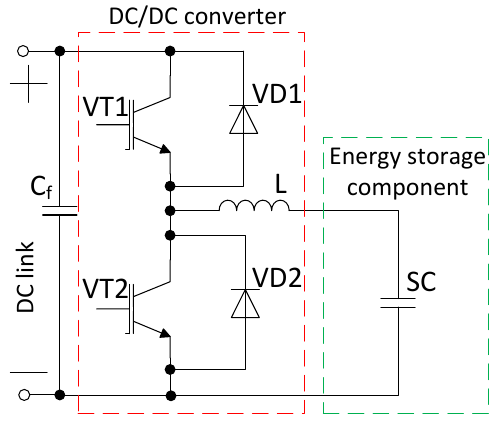
Fig. 2. Diagram of SC and DC/DC converter